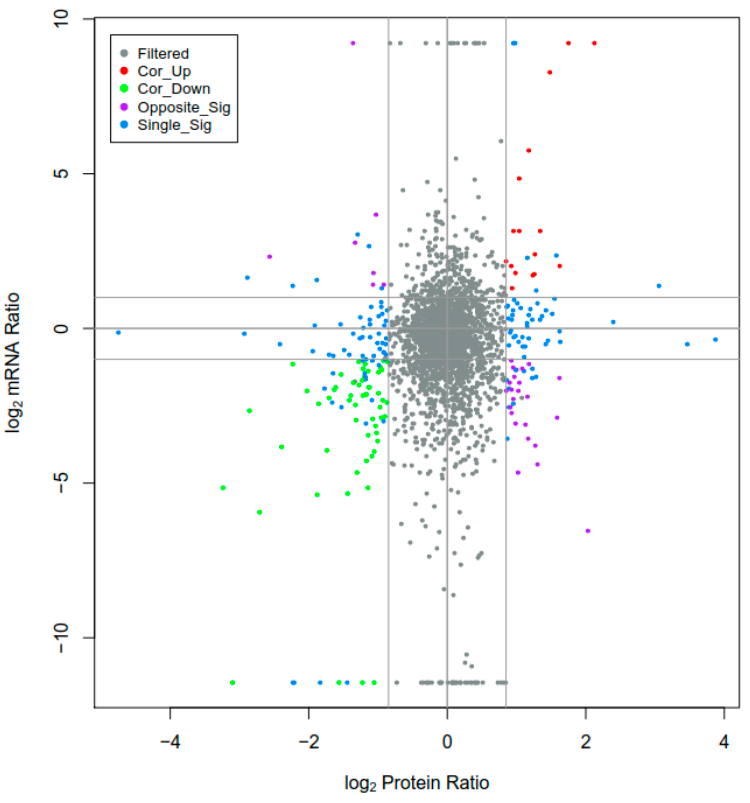
Figure 4. Relationship patterns of total mRNA and protein. The X -axis shows protein expression, and the Y -axis represents gene expression. Gray dots indicate genes and proteins with no significant difference, red dots represent upregulated genes and proteins, green dots represent downregulated genes and proteins, purple dots represent differentially expressed genes (DEGs) and differentially expressed proteins (DEPs) that show opposite regulation, and blue dots represent that one of the genes and proteins differ.